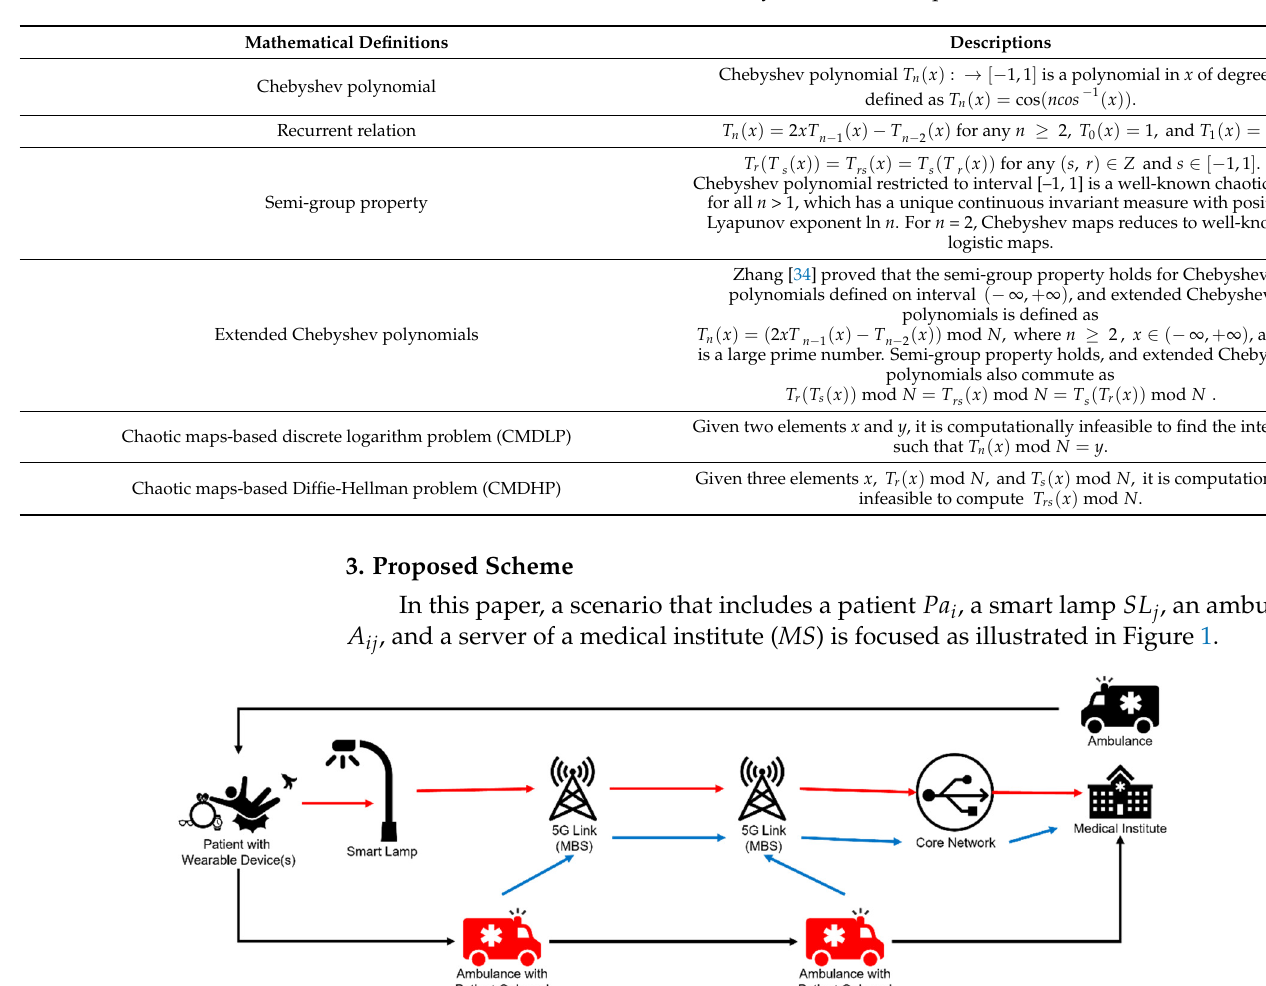
Table 1. Mathematical definitions of Chebyshev chaotic maps.